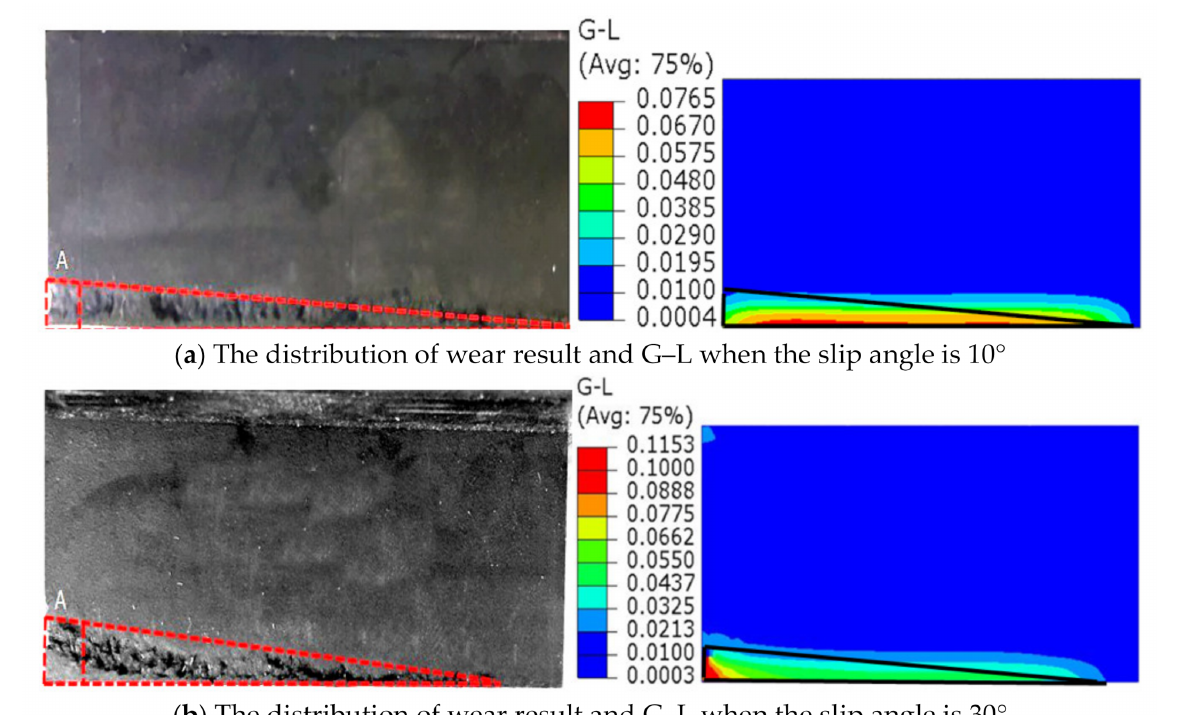
Figure 12. The changes of the slide surface with slip angle.